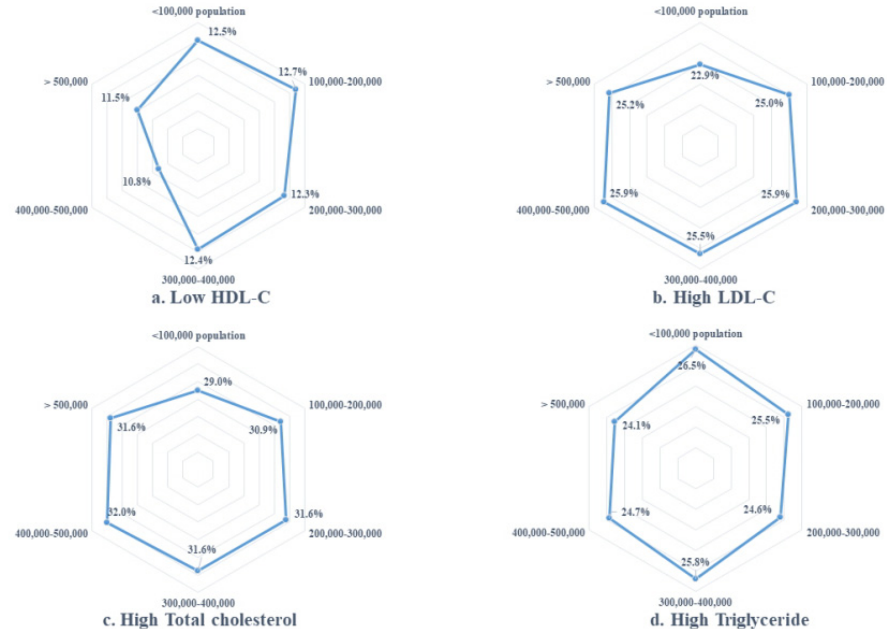
Figure 2. Regional disparities for abnormal serum cholesterol levels. The percentages represent patients with high (TC: ≥ 240 mg/dL, TG: ≥ 200 mg/dL, LDL-C: ≥ 160 mg/dL) or low (HDL-C: <40 mg/dL) serum cholesterol levels.